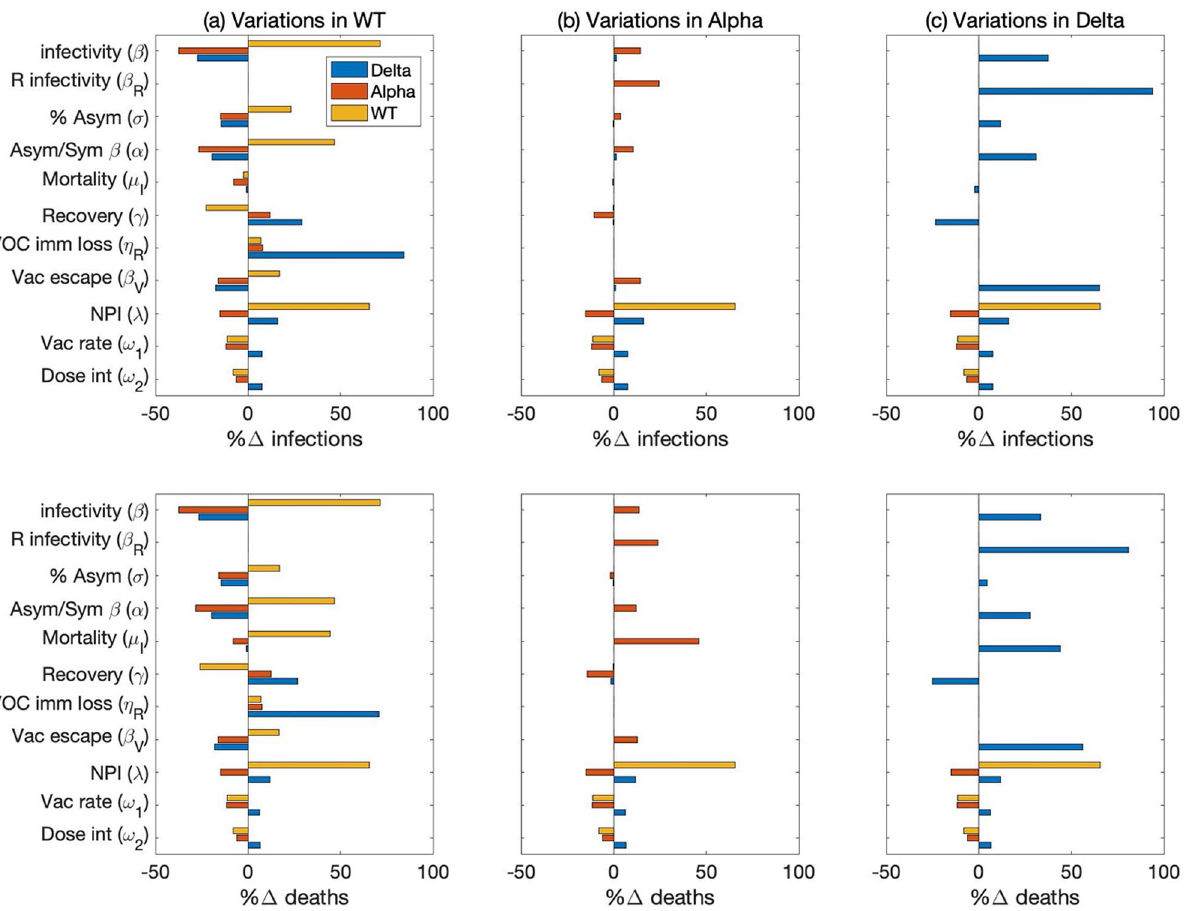
Figure 5. Sensitivity of model predictions, measured by total infections and deaths, to increases in model parameter values, in a two-year simulation interacting VOC dynamics. Parameters are varied individually for wild-type (column a), Alpha (column b), and Delta (column c). Relative changes in the number of infections and deaths are then computed for wild-type (yellow bars), Alpha (red bars), and Delta (blue bars). Parameter examined include virus infectivity (β), rate of infection of individuals recovered from a different variant (β R ), ratio of asymptomatic versus symptomatic infections (σ), degree of increased infectivity β (due to mobility) of asymptomatic infected individuals compared to symptomatic ones, mortality rate of infected individuals (μ I ), disease recovery rate (γ), rate of loss of immunity due to infection (η R ), vaccine escape rate (β V ), NPI stringency (λ), dosing interval (ω 2 ), vaccination rate (ω 1